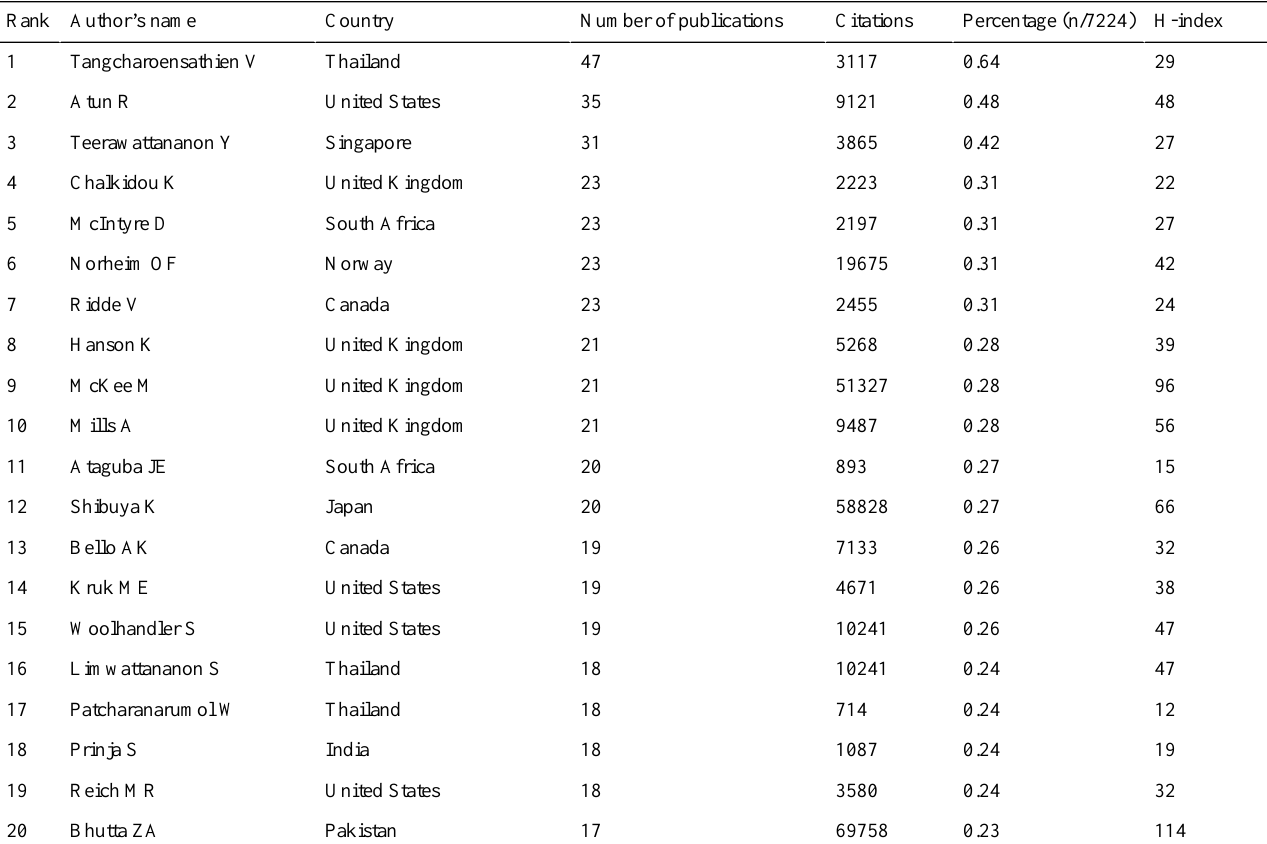
Table 2. Authors with the highest number of manuscripts related to universal health coverage.